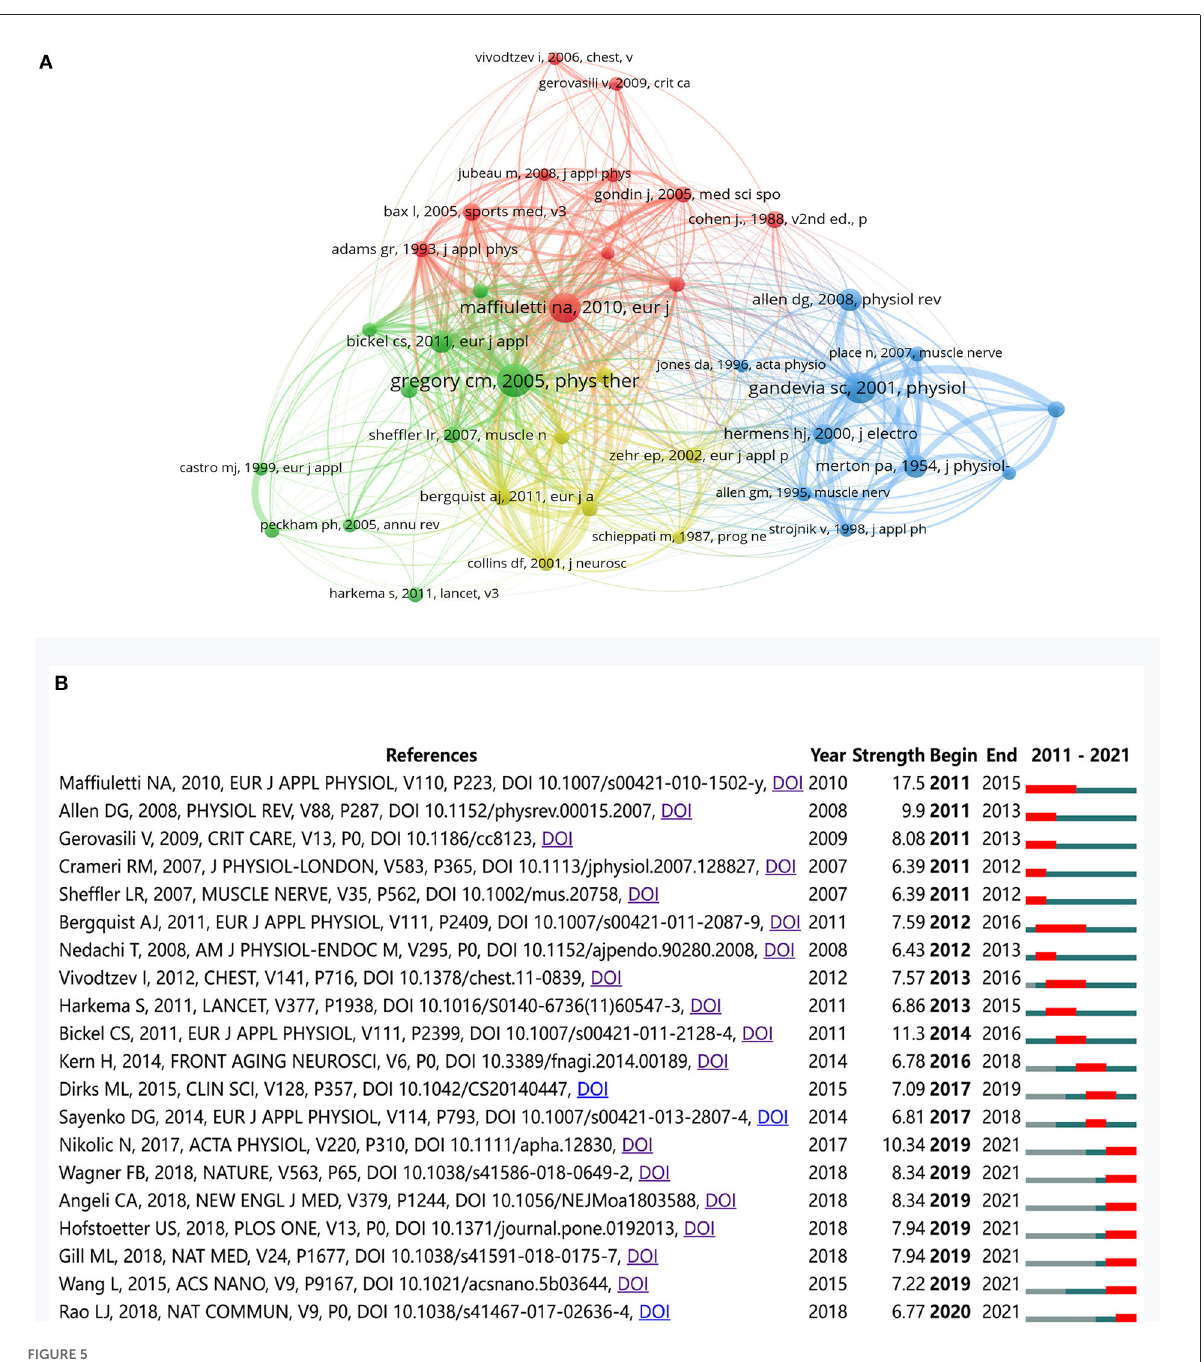
are significant application fields. Therefore, we speculate explain the molecular mechanisms at the neuroscientific and